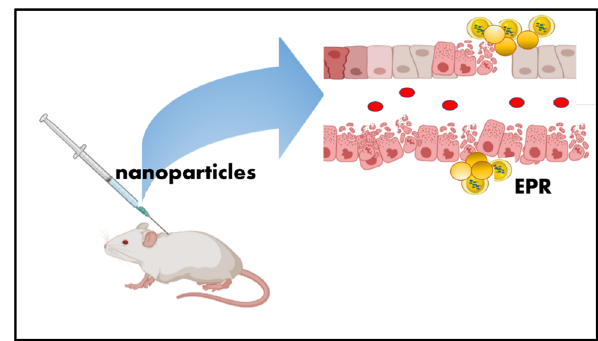
Figure 1: Schematic sketch of